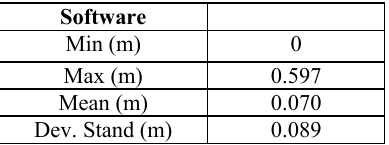
Table 7: Statistical values of the comparisons between the